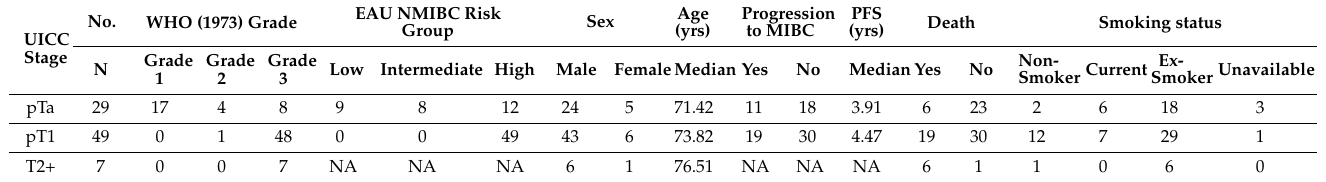
Table 5. Tumour cohort characteristics.